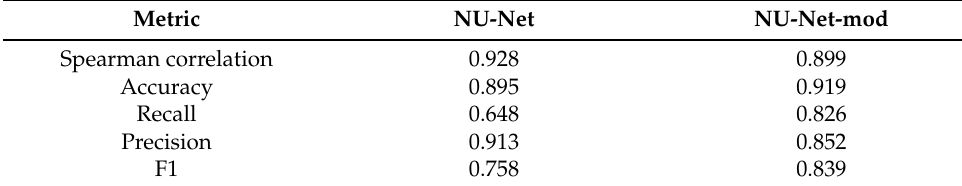
Table 5. Metric results of NU-Net and NU-Net-mod on the embedded device.